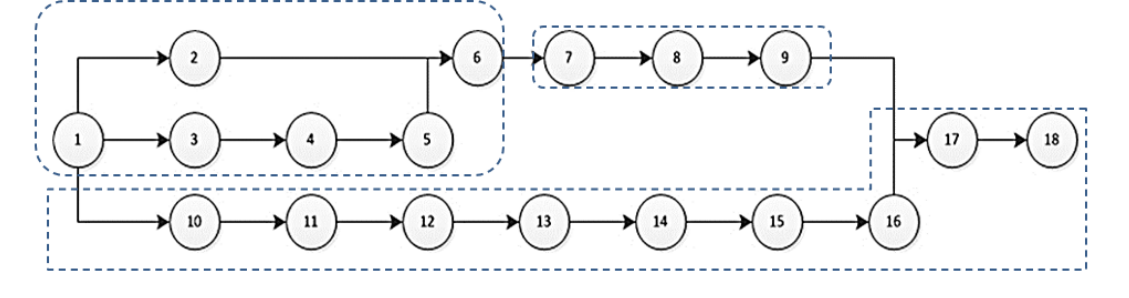
Figure 1. Workstation diagram of the current state of the factory.